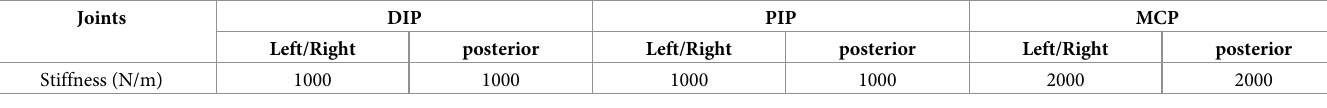
DIP: Distal interphalangeal joints. PIP: Proximal interphalangeal joints. MCP: Metacarpophalangeal joints.